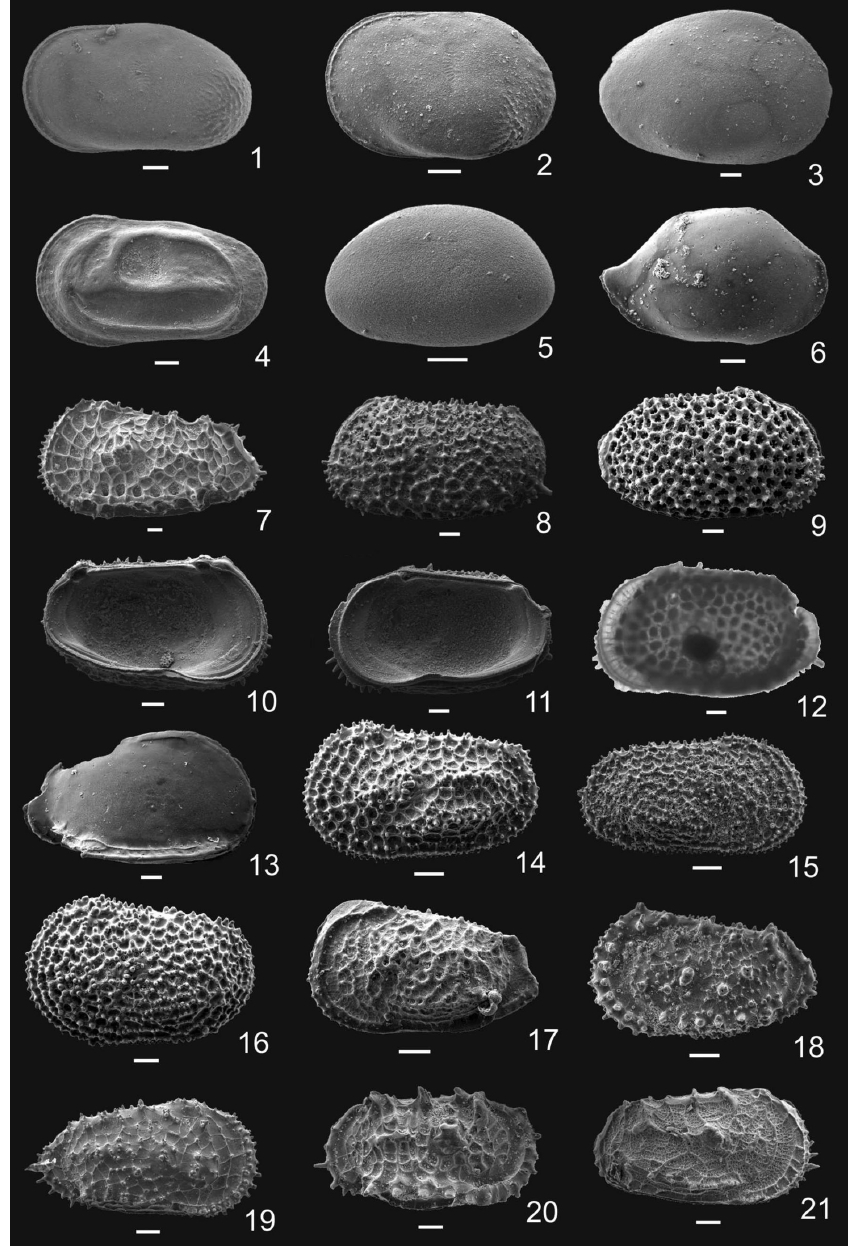
Fig. 3 – 1. Cytherella sp. 1, LV, 119-744A-19H-5W-5; 2. Cytherella sp. 2, LV, 119-744A-18H-3W-6; 3. Cytherella sp. 3, RV, 119-744A- 20H-1W-6; 4. Cytherelloidea sp., LV, 119-744A-18H-3W-6; 5. Australoecia sp., LV, 119-744A-16H-5W-4; 6. Bairdoppilata hirsuta (Brady), RV, 119-744A-19H-5W-5; 7. Agrenocythere hazelae (Bold), LV, 119-744A-11H-1W-7; 8-12. Anebocythereis hostizea (Hornibrook). 8. LV, 119-744A-19H-2W-5; 9. RV, 119-744A-16H-5W-4. 10. LV internal view, 119-744A-15H-1W-6; 11. RV internal view, 119-744A-18H-1W- 4. 12. RV internal view in optical microscopy. 13. Pseudobosquetina nobilis Jellinek et al., RV, 119-744A-16H-5W-4; 14. Henryhowella asperrima , LV, 119-744A-14H-3W-6. 15. Henryhowella sp. 1, RV, 119-744A-14H-3W-6; 16. Henryhowella sp. 2, LV, 119-744A-16H-2W-4; 17. Pennyella praedorsosserata Coles and Whatley, LV, 119-744A-18H-1W-4; 18. Legitimocythere presequenta (Benson), LV, 119-744A-16H- 4W-5; 19. Taracythere sp., RV, 119-744A-19H-2W-5; 20. Dutoitella suhmi (Brady), RV, 119-744A-20H-1W-6; 21. Dutoitella sp. 1,